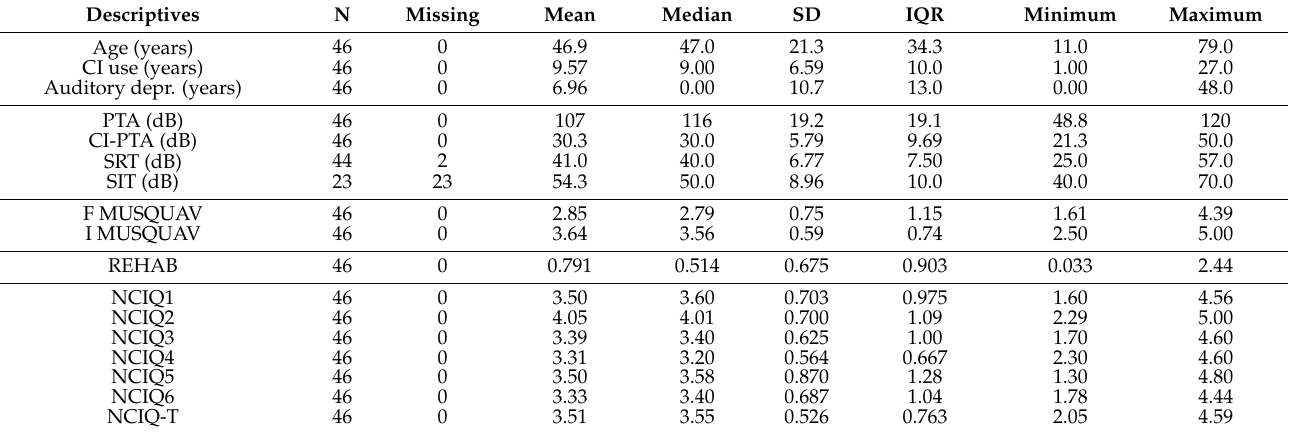
Table 5. Demographic, clinical characteristics, audiological outcomes, and PRO measures of the Frequencies of Gender, Onset, and Rehabilitation—REHAB group.